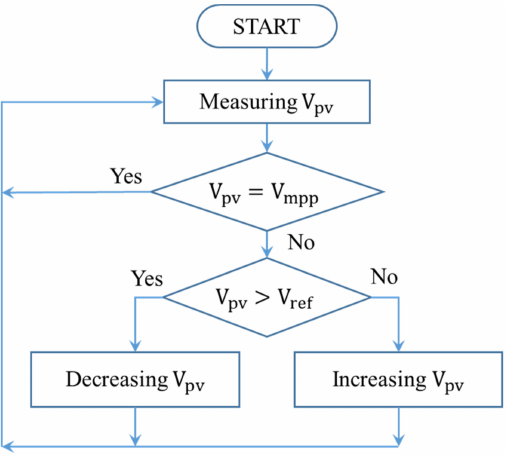
Figure 2. Flowchart of CV method.